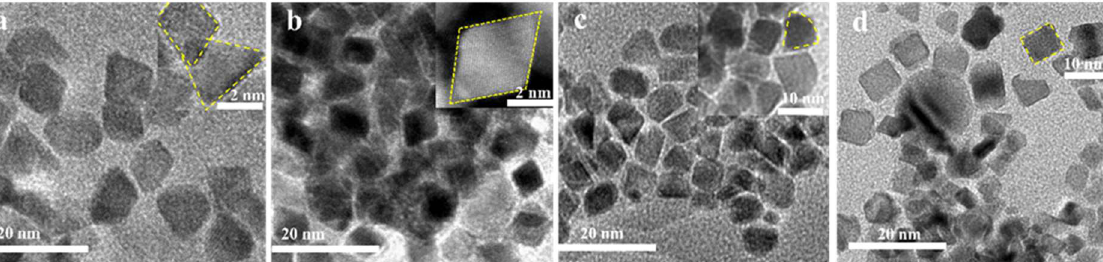
Figure 2. ( a – d ). TEM images of Pd-Pt-Ni ternary alloy catalyst obtained at different deposition times: ( a ) 3; ( b ) 6; ( c ) 9; ( d ) 12 h.